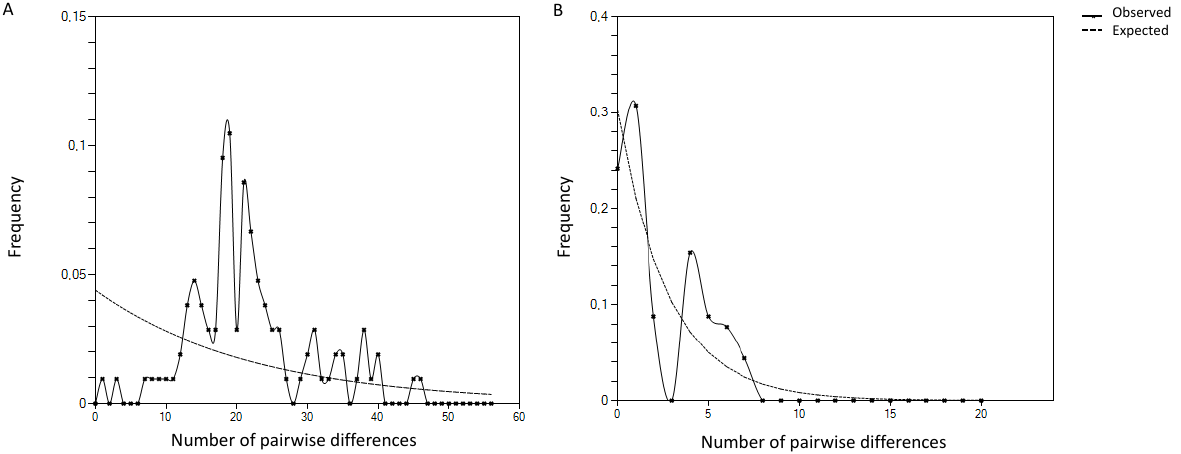
Figure 4. Mismatch distribution of ITS ( A ) and COI ( B ) sequences of five Portuguese isolates of Pratylenchus penetrans